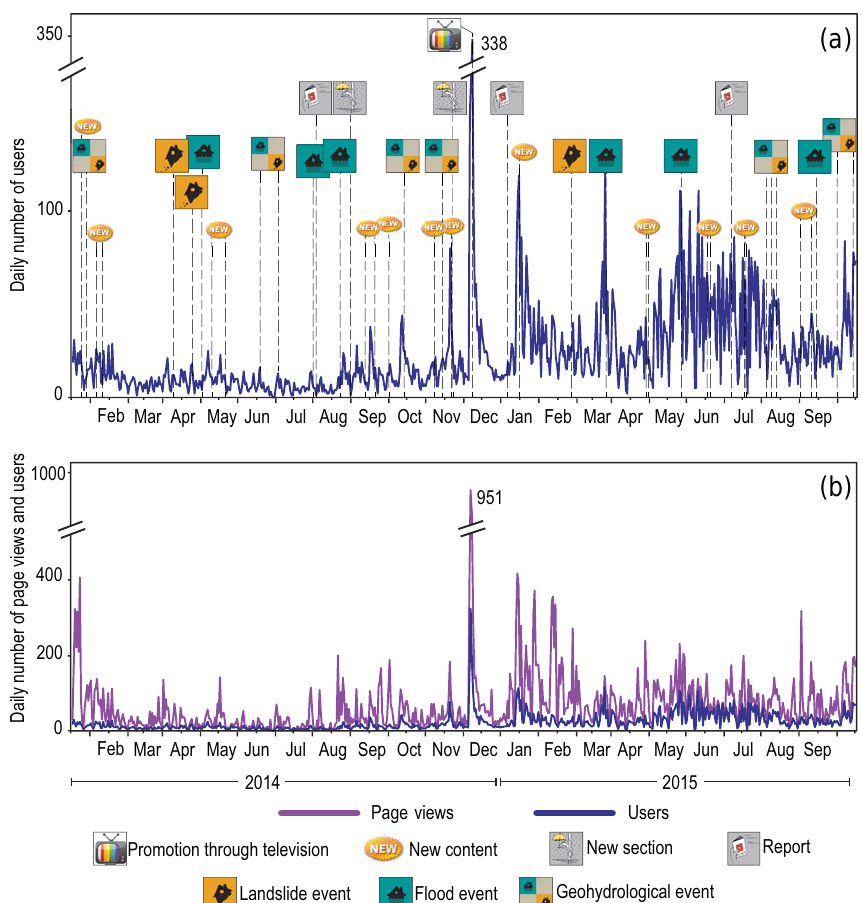
Figure 6. (a) Daily number of users of the POLARIS web site in the 638-day period from 16 January 2014 to 15 October 2015. (b) Daily number of page views (violet line) and users (blue line) in the same